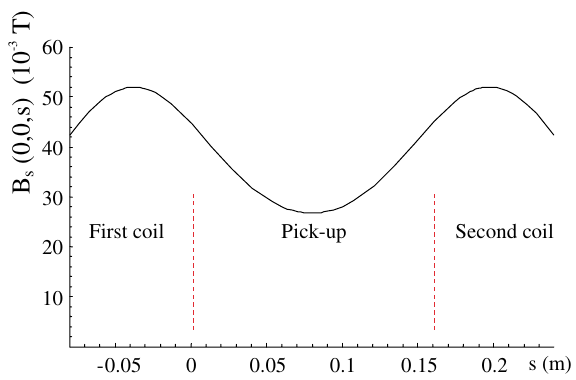
FIG. 9. (Color) Absolute value of the longitudinal component (cid:7) 0 ; 0 ; s (cid:8) generated by the two coils of the magnetic field B s installed at both ends of the wide-band electrostatic pickup for the maximum